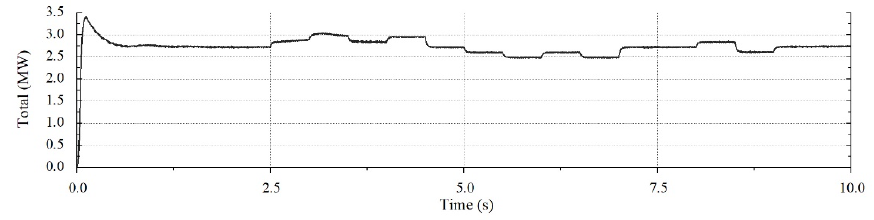
Figure 9. Power supplied quantity from main grid (non-ESS).